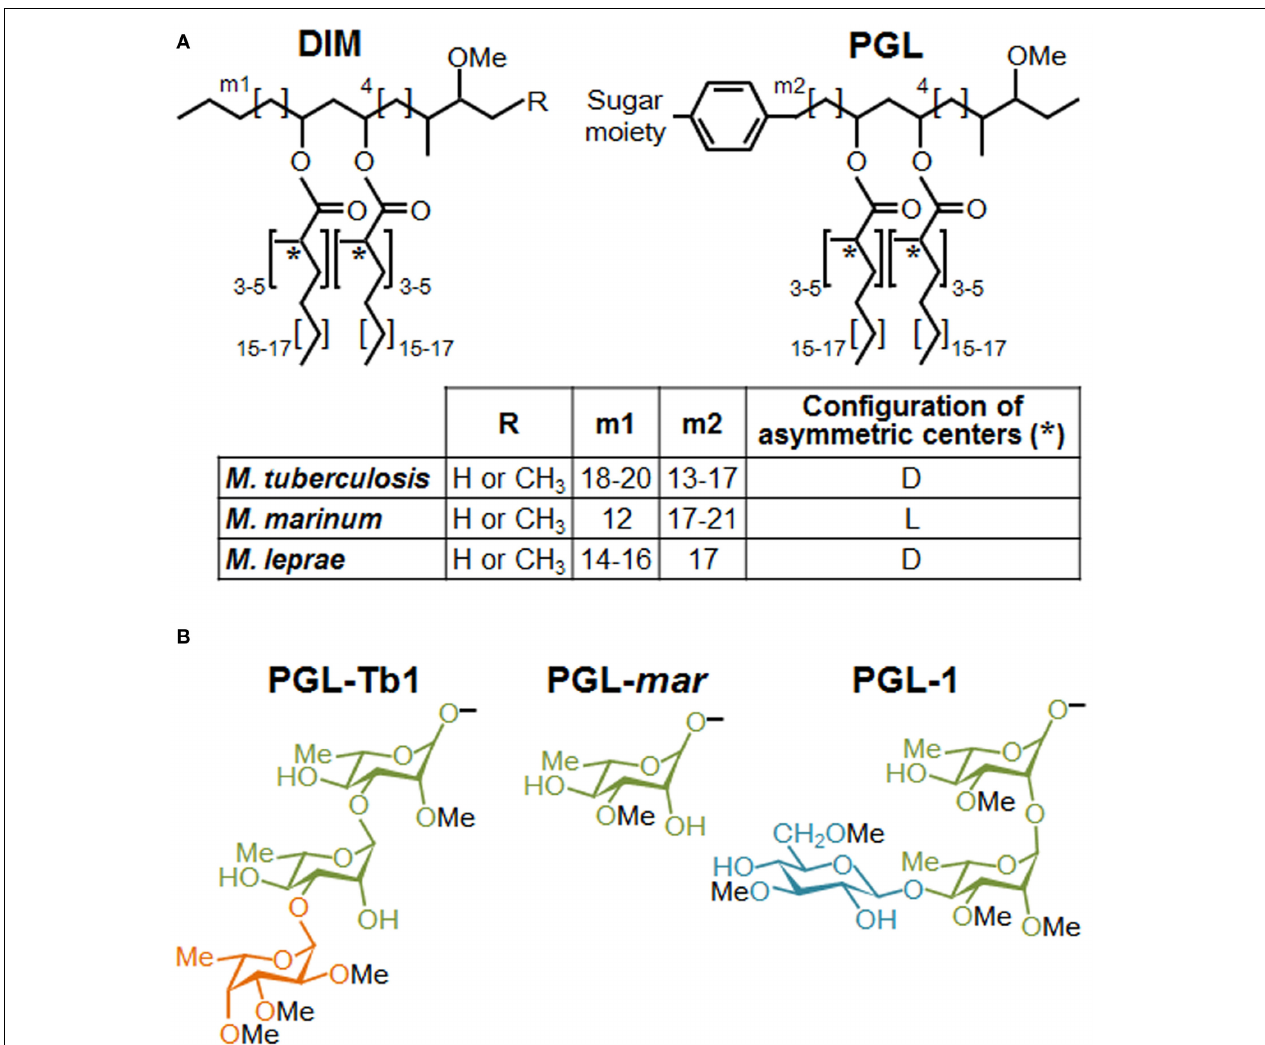
FIGURE 1 | Structures of DIM and PGL produced by various mycobacterial species. (A) Structure of the major DIM and PGL lipid moieties. The lipid core is composed of a long-chain β -diol (phthiocerol and phenolphthiocerol), showing slight length variations (see m1 and m2 values in embedded table), esterified by polymethyl-branched fatty acids. In most cases, the configuration of the asymmetric centers bearing the methyl branches (asterisks) are of the D series, mycocerosic acids, but in